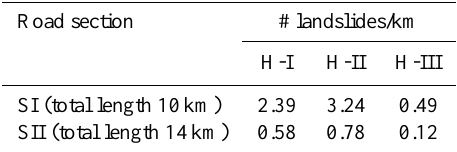
Table 2. Landslide hazard along the railway line in T 50 years return period.